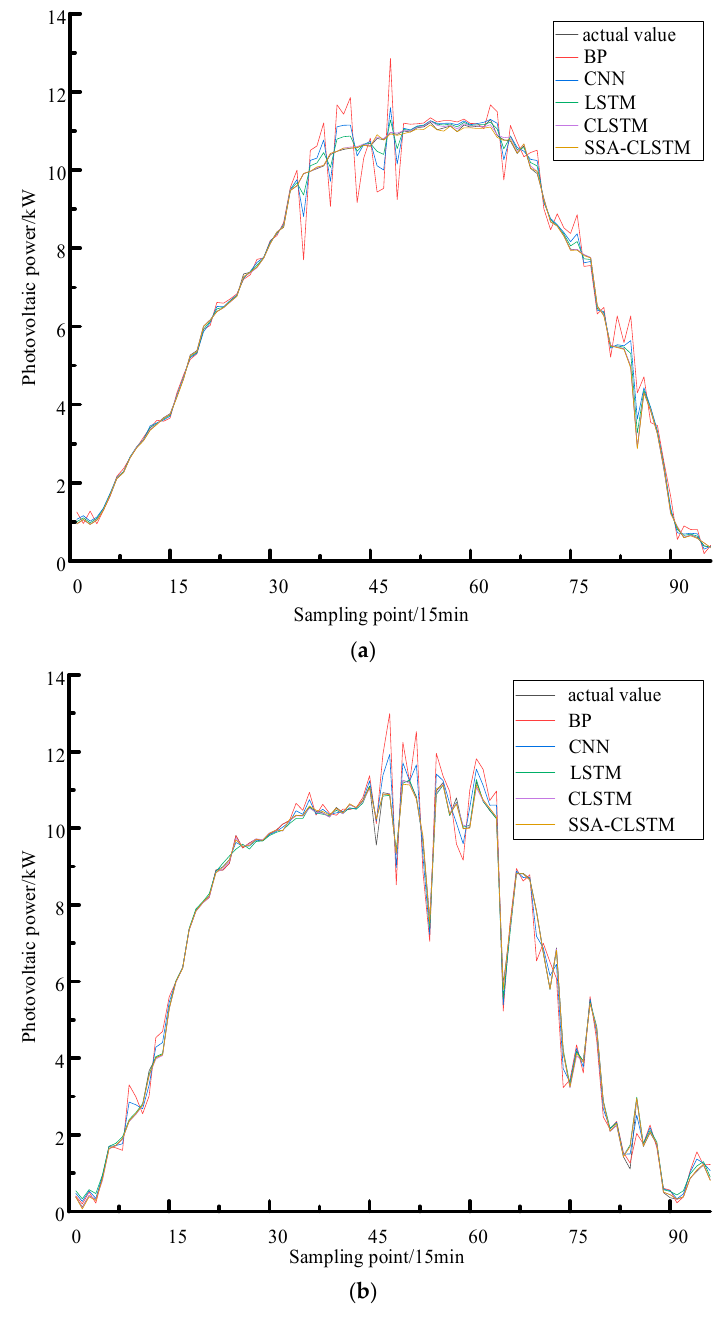
Figure 9. The prediction results of different prediction methods under the two weather types.